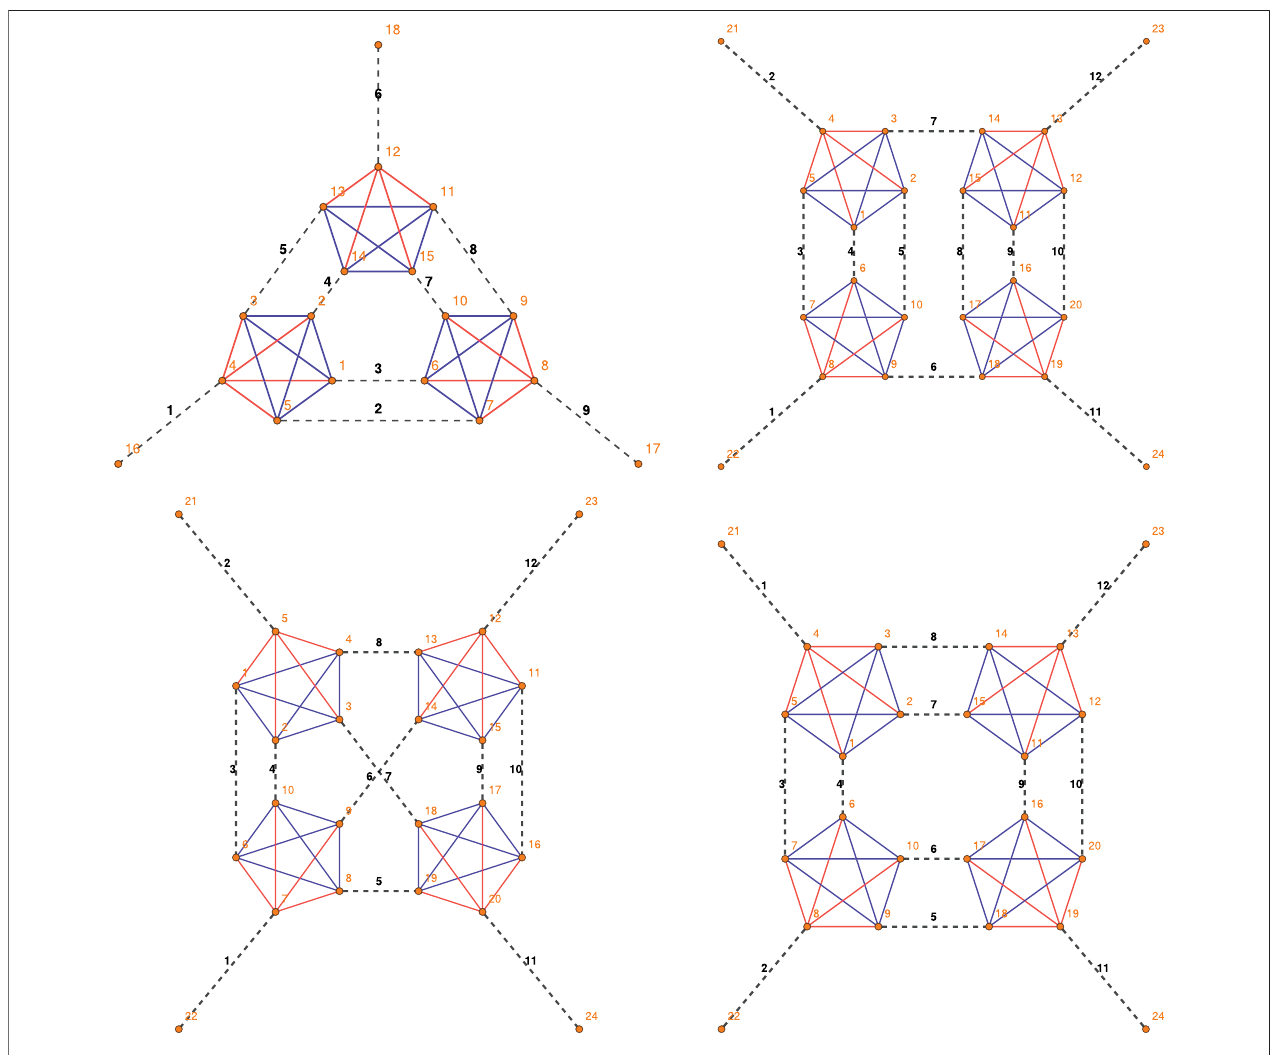
FIGURE 3 | Example of GFT diagrams of the type G N